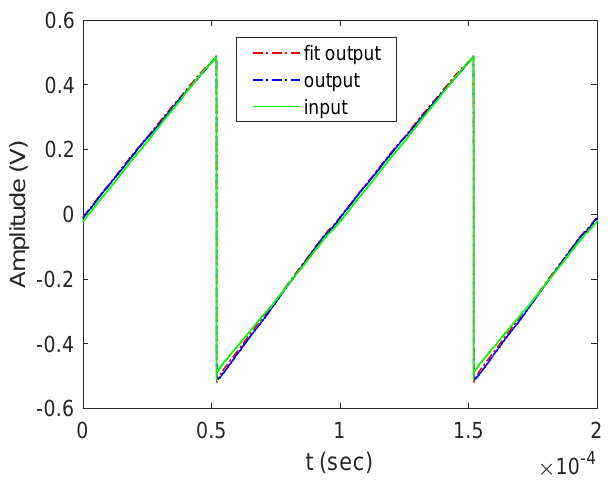
Figure 15. Measured and fitted sawtooth response with four transformers, γ = 4 and R IN = 11 Ω in Figure 8 and Equation (9), superimposed onto a 10 kHz input signal. Fitted and measured signals are indistinguishable. Signals are normalized in amplitude.